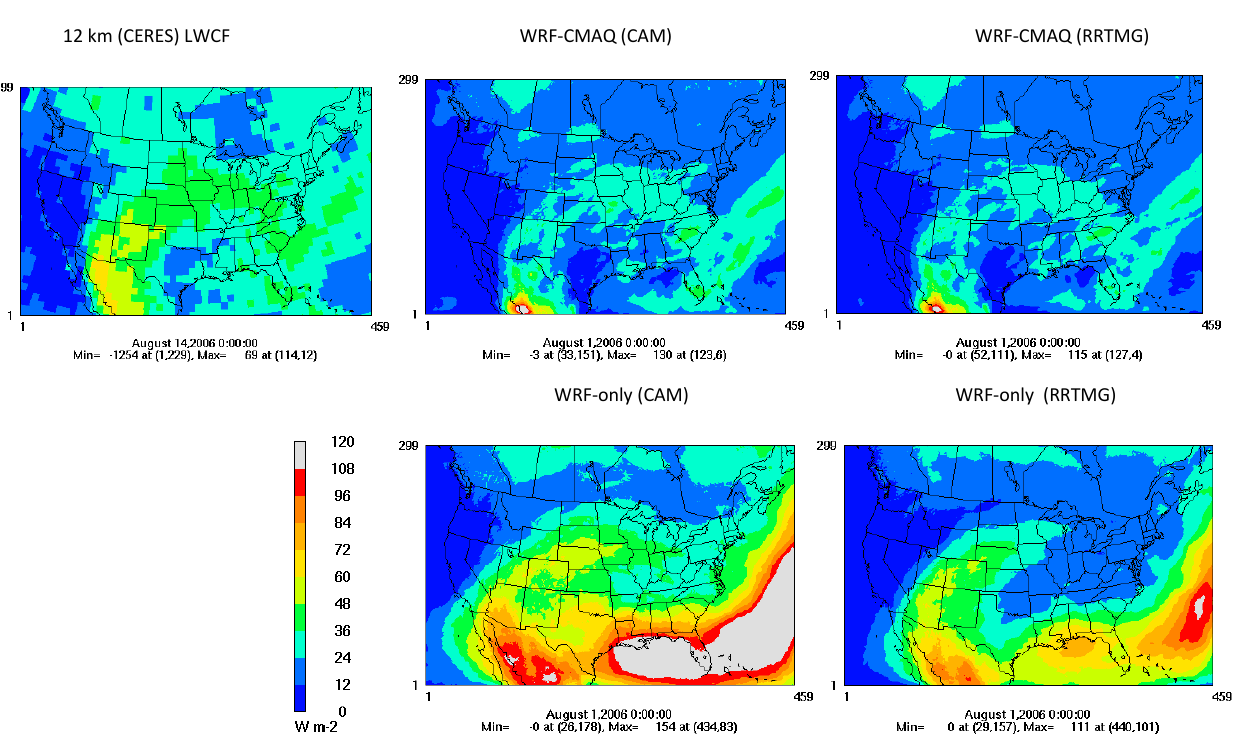
Figure 13. Same as Figure 9 but for LWCF